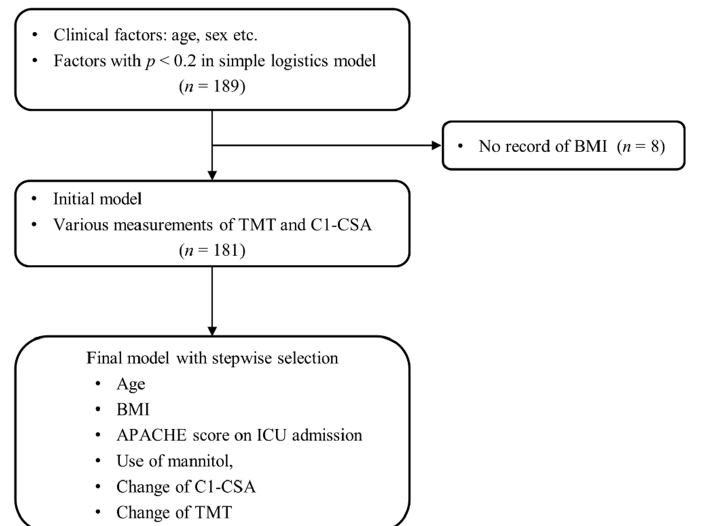
Figure 4. The process of selecting variables for the regression model. Abbreviations: BMI, body mass index; ICU, intensive care unit; APACHE, Acute Physiology and Chronic Health Evaluation; C1-CSA, the cross-sectional area of the paravertebral muscle at first cervical vertebra; and TMT, temporalis muscle thickness. Table 3. Association between factors and poor neurologic outcome at 3 months.